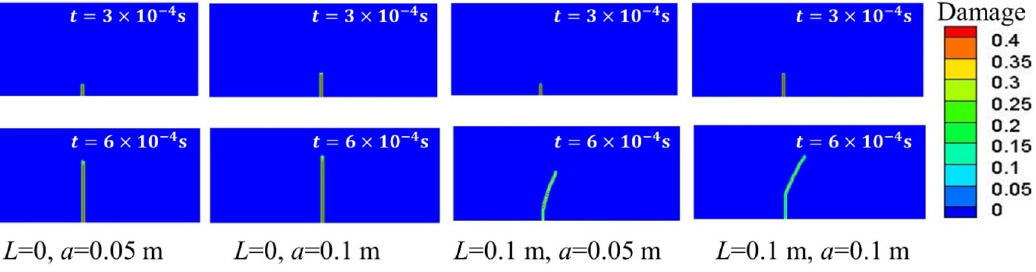
Figure 7. Crack patterns for these four loading cases at time t = 3.0 × 10 − 4 s and t = 6.0 × 10 − 4